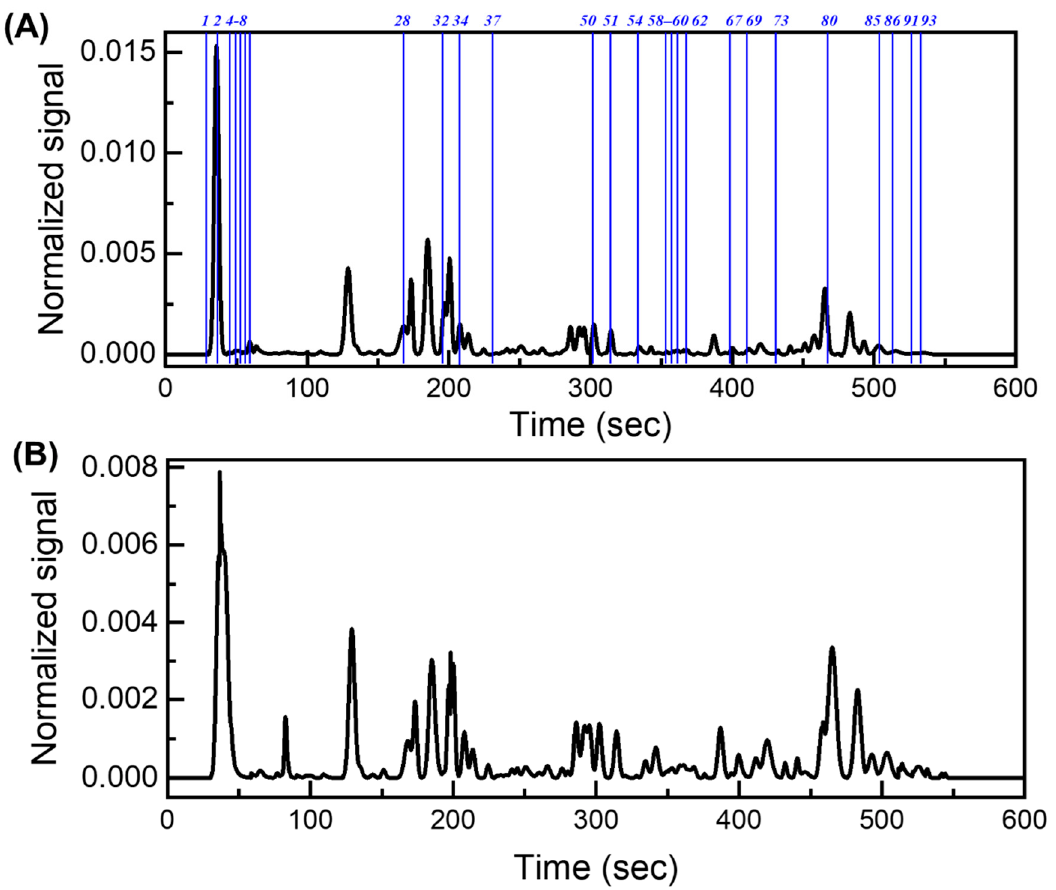
Figure 1. Representative GC chromatogram from an asthma patient ( A ) and a non-asthma/non-atopic ( B ). The blue lines and numbers mark the peak positions of the identified biomarkers listed in Tables 2 and 3.